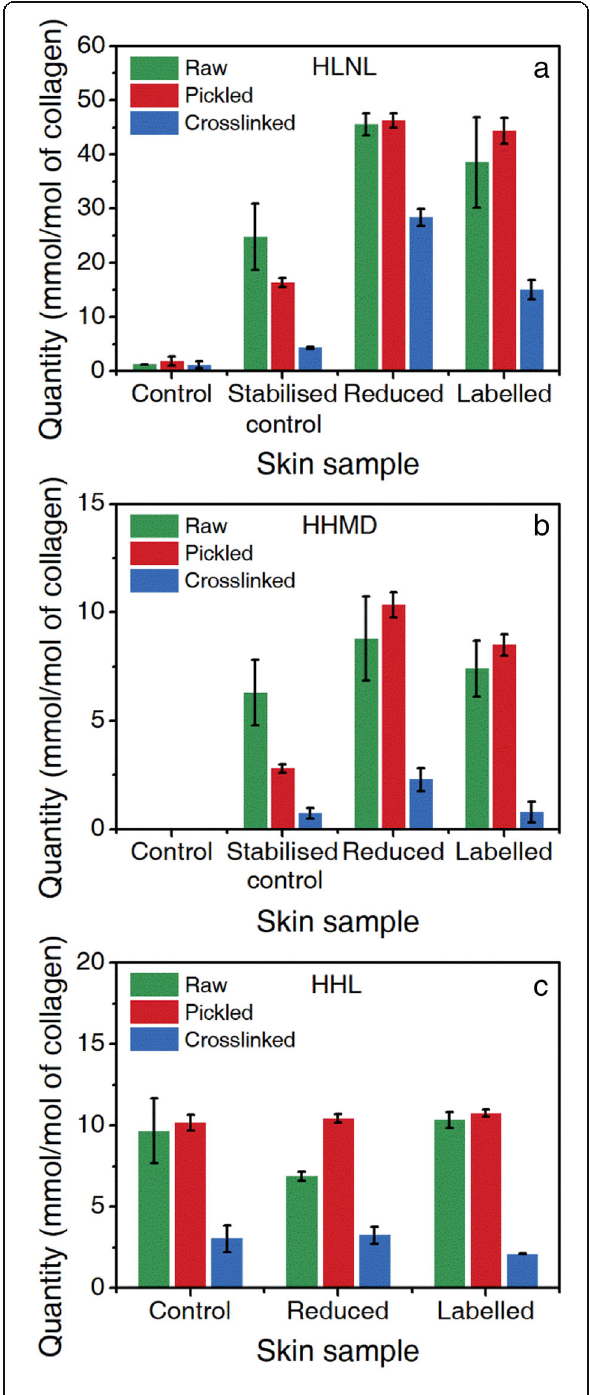
Fig. 3 Concentration of natural crosslinks in skin sample at different processing stages. a , b Control samples measured as-prepared showed no HLNL and HHMD due to the strong acidic condition during hydrolysing step of sample preparation (to quantify HLNL and HHMD in control samples, stabilisation using NaBH 4 prior to acid hydrolysis is required). HLNL and HHMD in stabilised control showed decreases in quantity when processed from raw to pickled stage. Further decreases were observed from pickled to crosslinked stage. c HHL can be observed in control, reduced and labelled skin samples, with no decrease during pickling but a significant decrease when